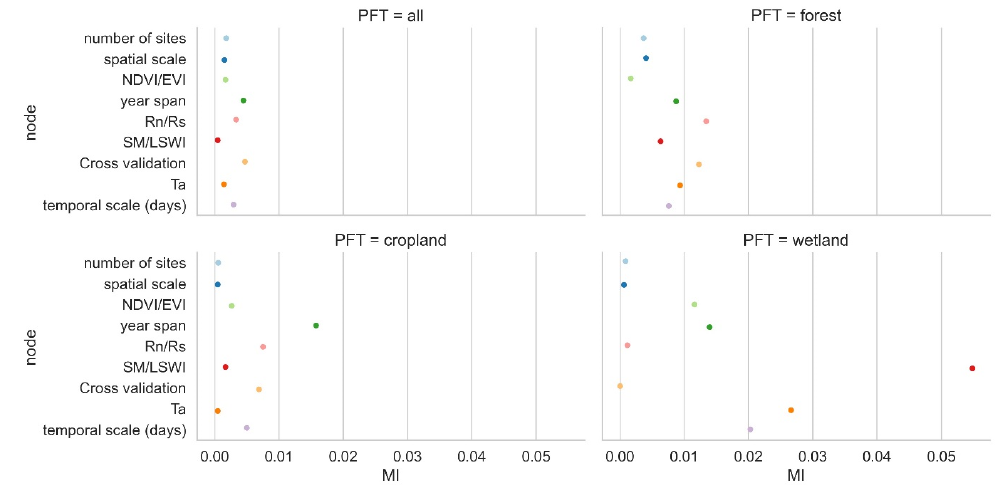
Figure 10. The sensitivity analysis of the R 2 node to other nodes based on the mutual information (MI) across PFTs. “Cross-validation” is the cross-validation method including spatial, temporal, and random